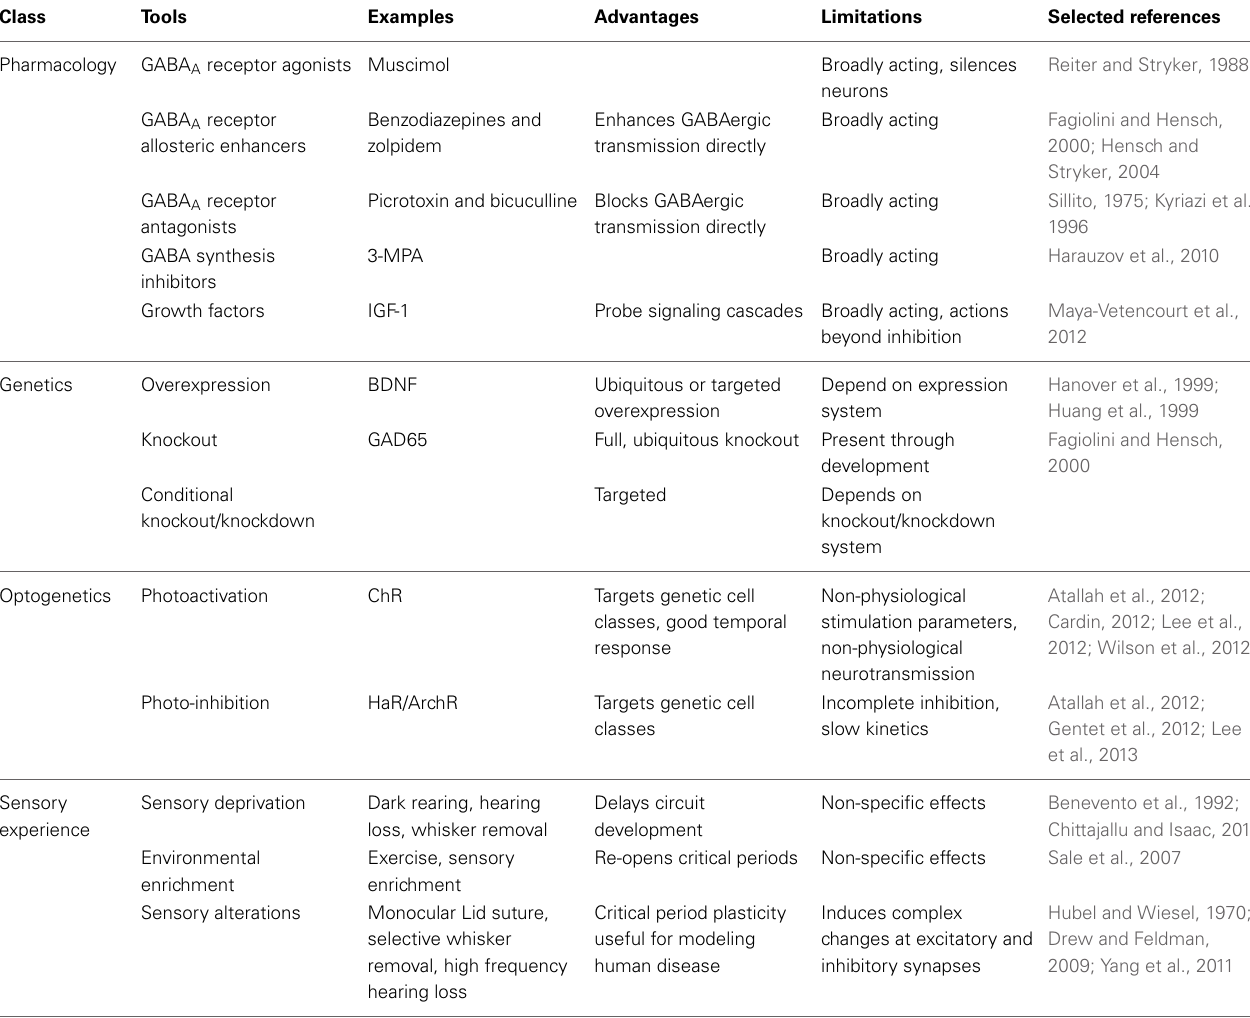
Table 2 | Tools for manipulating inhibition in vivo